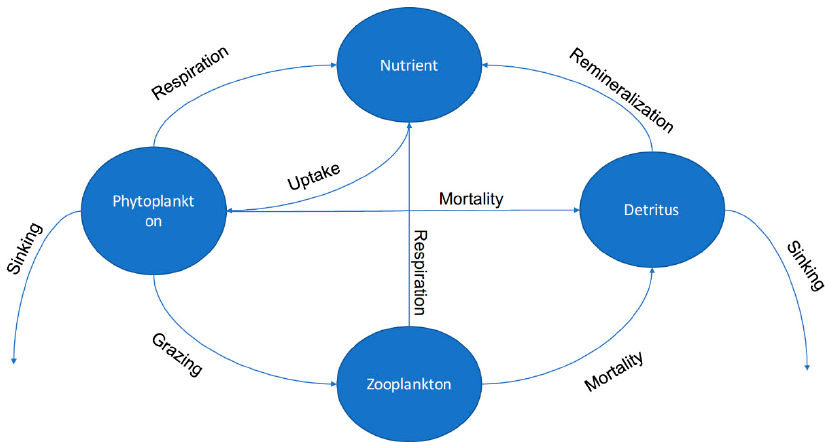
Figure 4. A schematic representation of the nutrient-phytoplankton-zooplankton-detritus (NPZD) model.